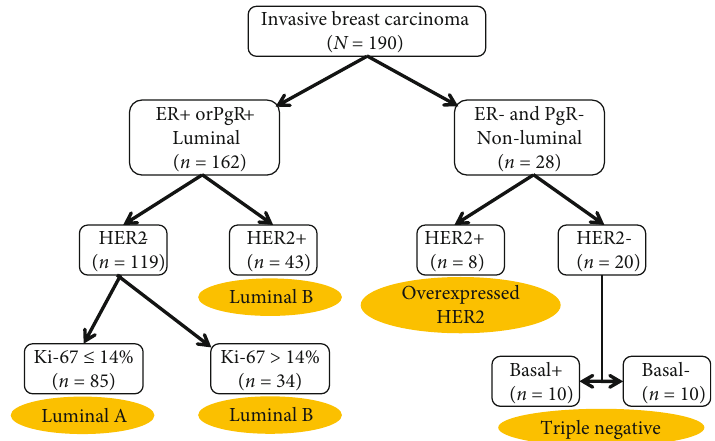
Figure 1: Classi fi cation of breast cancer subtypes by immunohistochemical marker pro fi le.